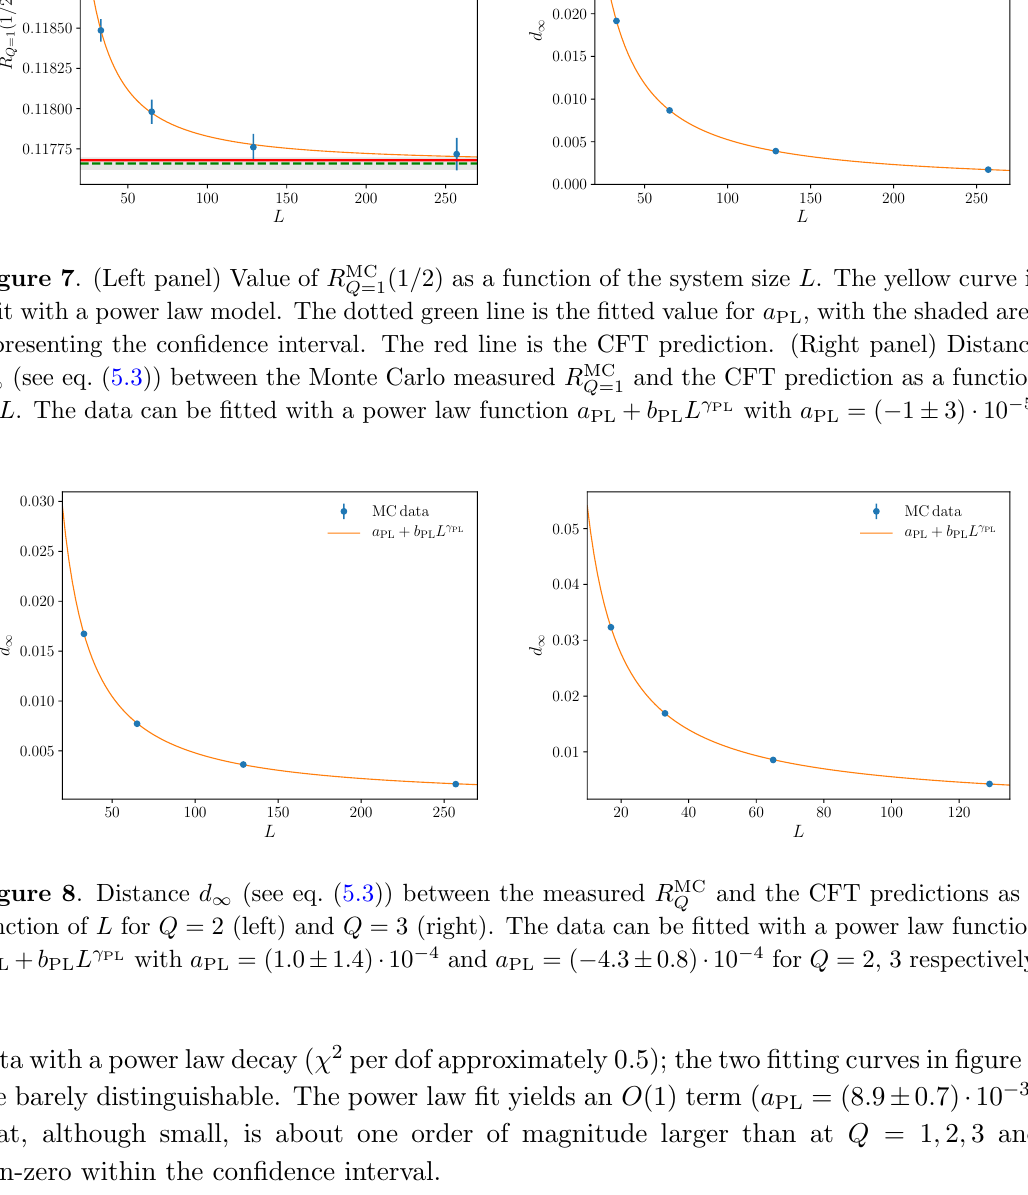
0 : 7) 10 (cid:0) 3 ) (cid:6) (cid:1)